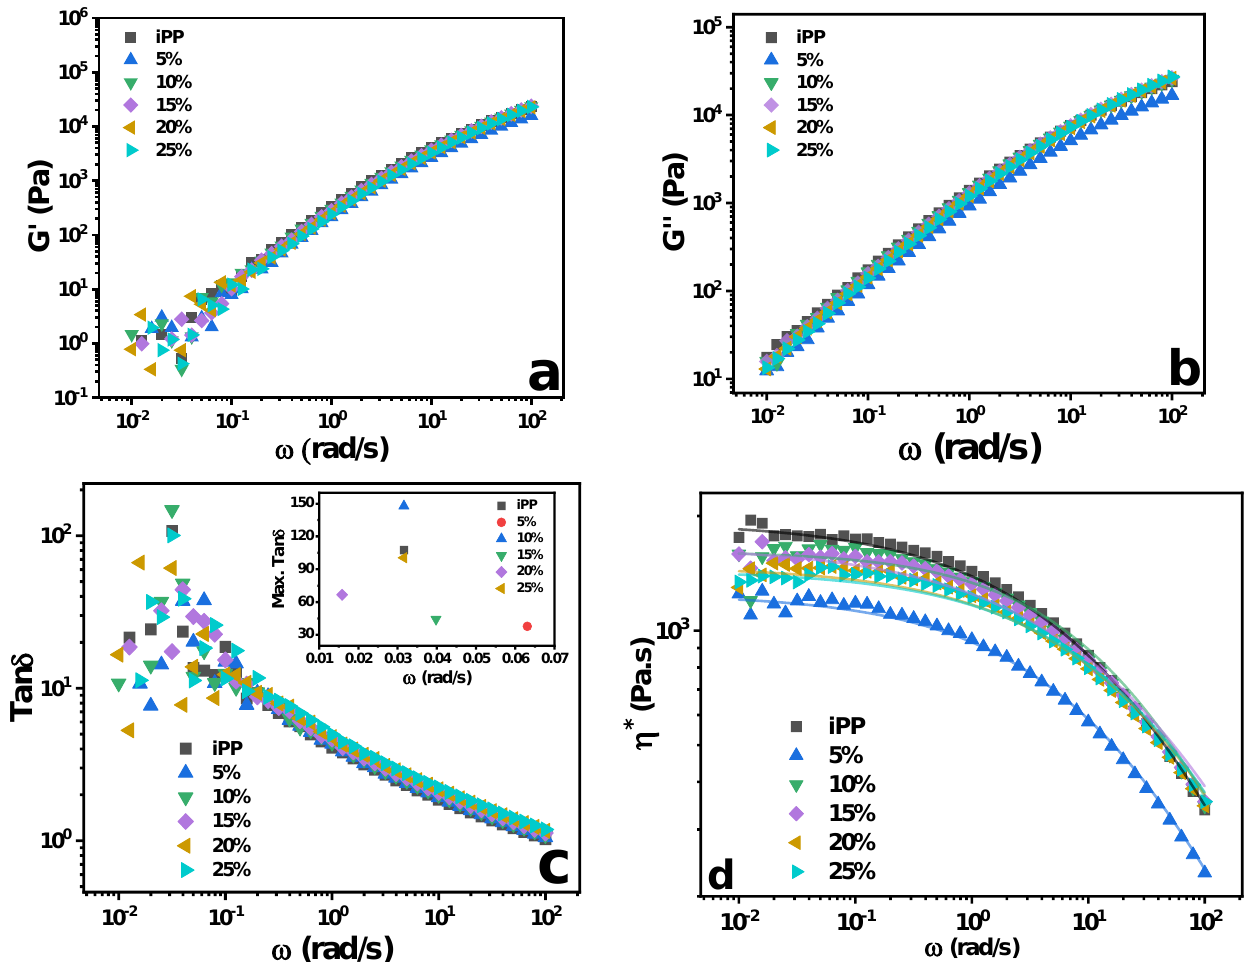
Figure 4. Dynamic rheological response for storage modulus (G (cid:48) ) ( a ), loss modulus (G (cid:48)(cid:48) ) ( b ), loss tangent (tan δ ) with inset (max. tan δ ) ( c ) and complex viscosity (* η ), line ‘fitted with Carreau-Yasuda model ( d ) as a function of angular frequency ( ω ) at γ = 0.5% and 1 50 °C for pure iPP, LMPP and blends.